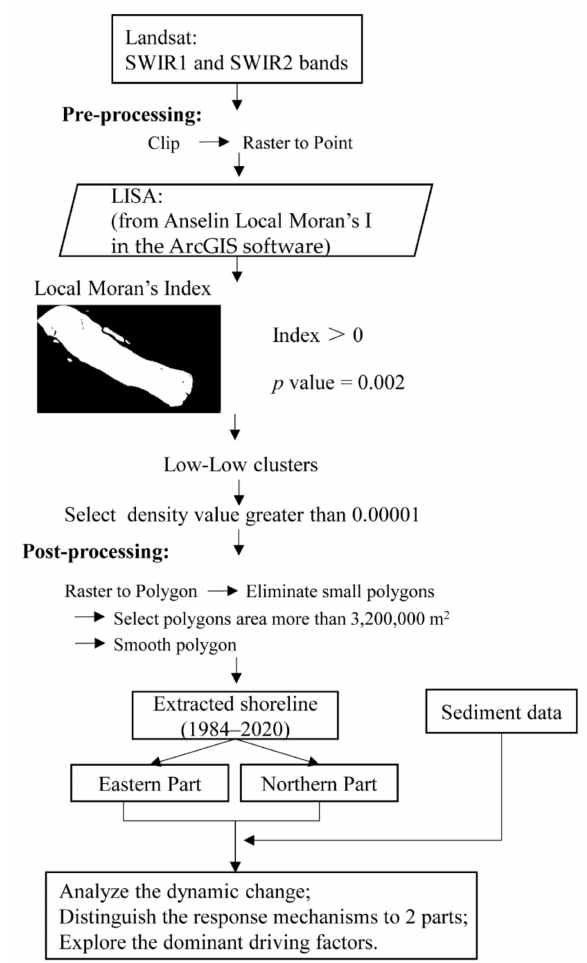
Figure 3. Methodology flowchart. SWIR1 is the first shortwave infrared band; SWIR2 refers to the second shortwave infrared band of the Landsat